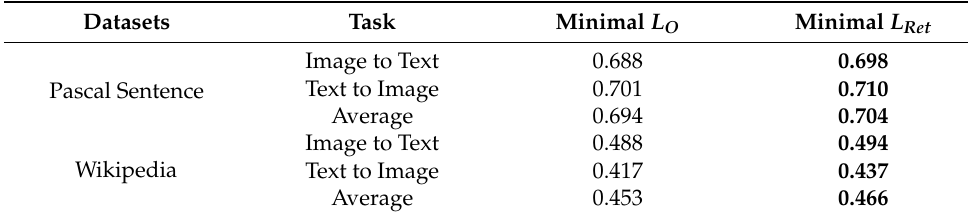
Table 6. The mAP values of the cross-modal retrieval results with minimal L O or L Ret .